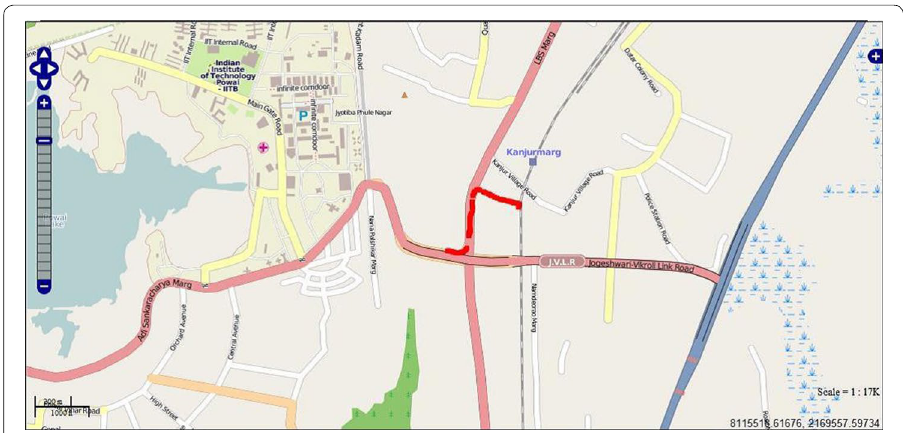
Fig. 1 User GPS traces plotted on Open street map